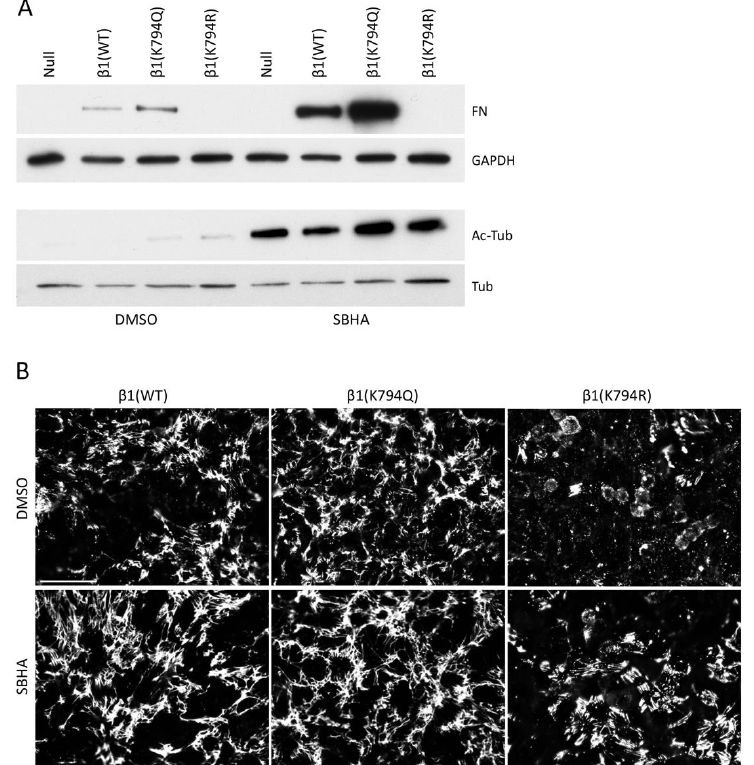
Figure 7. Lysine acetylation of additional proteins is necessary for maximum FN matrix assembly. GD25 cells were treated with 5 μM SBHA or DMSO for 24 h before DOC lysis and immunoblotting of DOC-insoluble FN ( A ) and immunofluorescence staining with anti-FN antiserum R184 for visualization of FN matrix ( B ). ( A ) DOC-soluble fractions were also immunoblotted with anti- GAPDH, anti-acetyl-tubulin, and anti-tubulin antibodies. Fold-changes in fluorescence intensities between DMSO and SBHA-treated cells were calculated and normalized to β1(WT) DMSO cells (set to 1). Values are 1.31 ± 0.01 (β1(K794Q) DMSO), 0.43 ± 0.01 (β1(K794R) DMSO), 1.26 ± 0.13 (β1(WT) SBHA), 1.61 ± 0.20 (β1(K794Q) SBHA), and 0.74 ± 0.15 (β1(K794R) SBHA). Representative images are shown for each condition. Scale bar = 50 µ